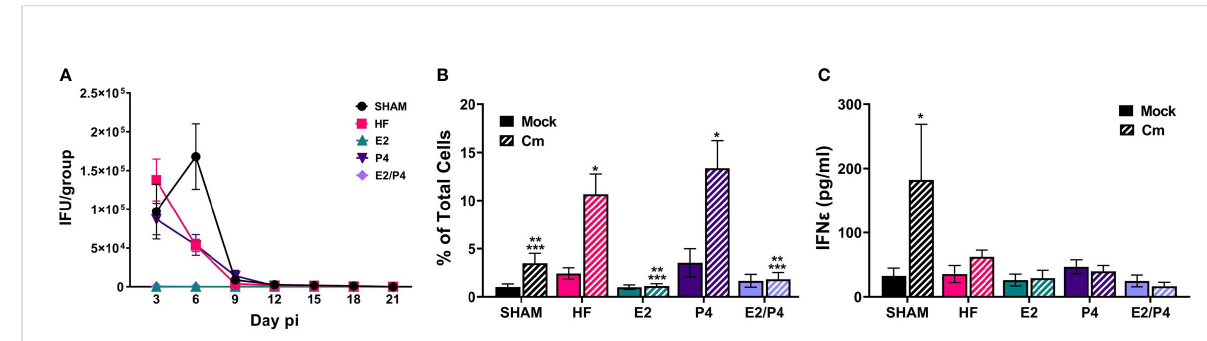
FIGURE 2 Sex hormones alter bacterial vaginal shedding and immune response to C muridarum (Cm) in infected ovariectomized mice. (A) . EB shedding was monitored by chlamydial titer assays from C muridarum infected, hormone-treated mice for 21 days pi. Data shown represent the average (n= 12-29 mice/group/day) IFU/group ± SEM. (B) Flow cytometry analysis was performed to detect CD3 positive T cells in the genital tracts of mock- or Cm infected, hormone-treated OVT mice at day 10pi. Data shown represent the average (n= 12 mice/group) percentage of total cells measured ± SEM. Asterisks indicate signi fi cant differences (P ≤ 0.05). *Cm vs mock, **HF (Cm), ***P4 (Cm), vs experimental group. (C) The concentration of IFN ϵ was detected in vaginal swab samples on day 3pi by ELISA. Data shown represent the average (n= 7 mice/group) IFN ϵ concentration ± SEM. Asterisks (*) indicate signi fi cant differences between Cm and mock infection (P ≤ 0.05).